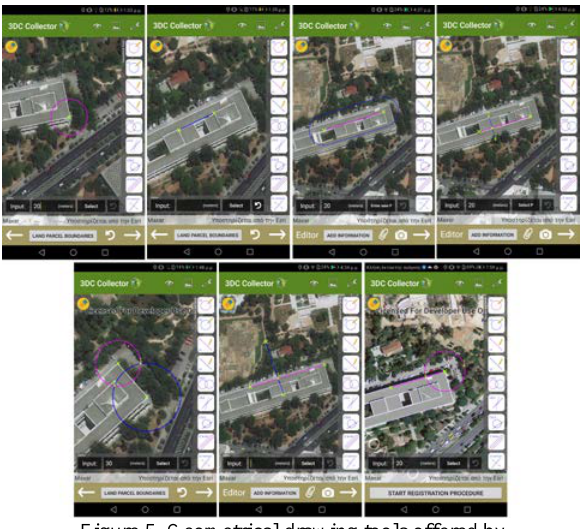
Figure 5. Geometrical drawing tools offered by BoundGeometry application. Top (left to right): circle, line, offset to line, vertical lines Bottom: intersection points between 2 circles, 2 lines, a circle and a line